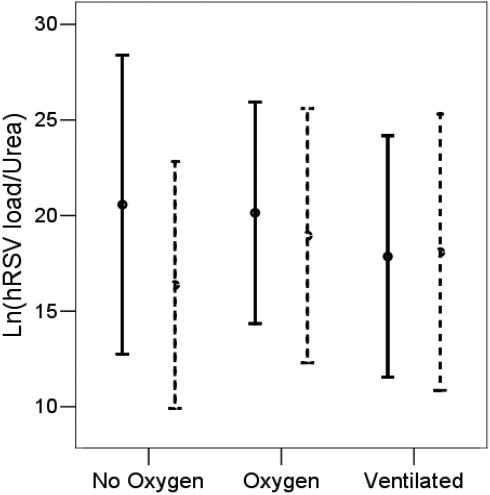
Cell-free hRSV load (expressed Ln(hRSV load/urea), geometric mean and 95% confidence intervals), in the nasopharyngeal aspirate of 104 infants grouped by worst severity of bronchiolitis during hospital admission and sub-grouped by term (solid lines) or preterm birth (dashed lines).